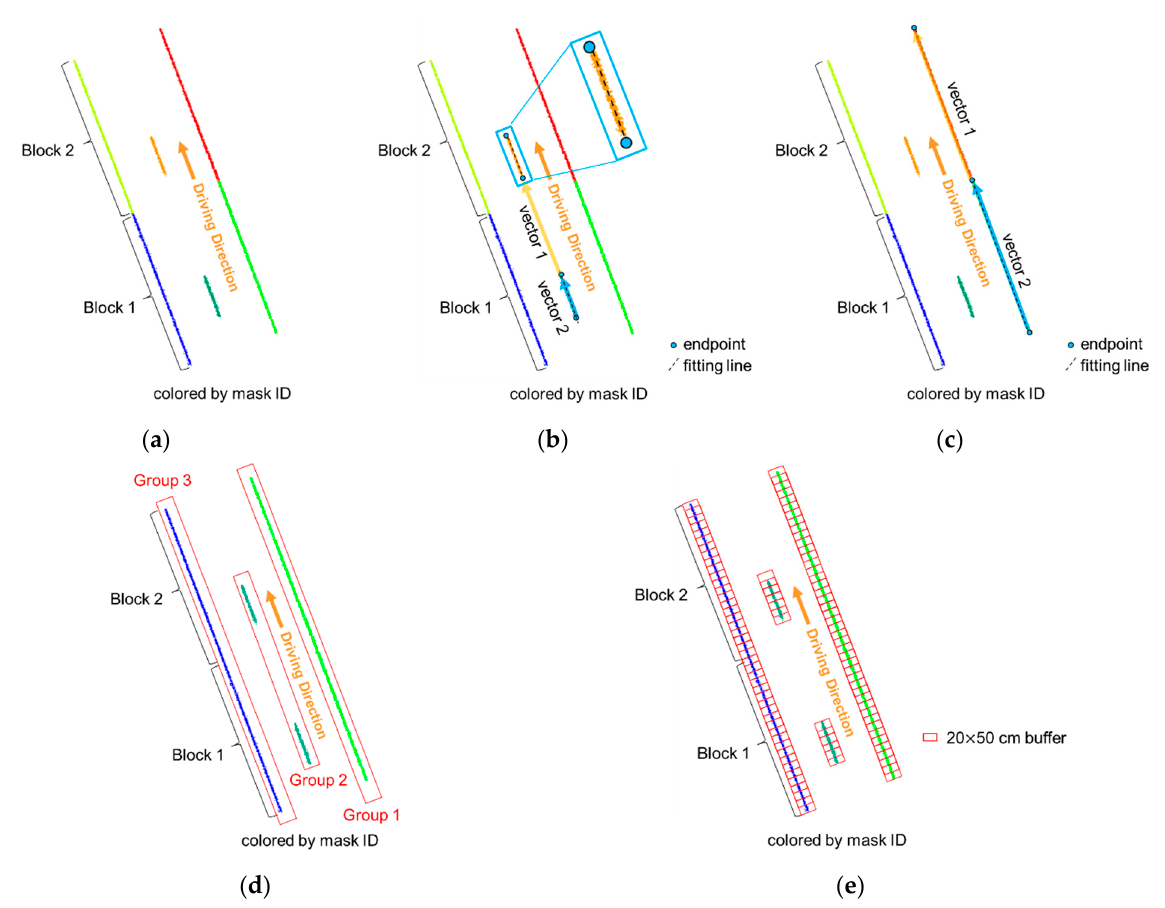
Figure 17. Graphical depiction of intensity profile generation algorithm: ( a ) lane marking segments in two consecutive blocks; ( b ) defining vectors 1 and 2 for grouping two segments in two blocks (endpoints > 40 cm apart); ( c ) defining vectors 1 and 2 for grouping two segments in two blocks (endpoints < 40 cm apart); ( d ) grouped segments; ( e ) partitioning of each grouped segment by 20 × 50 cm buffers.